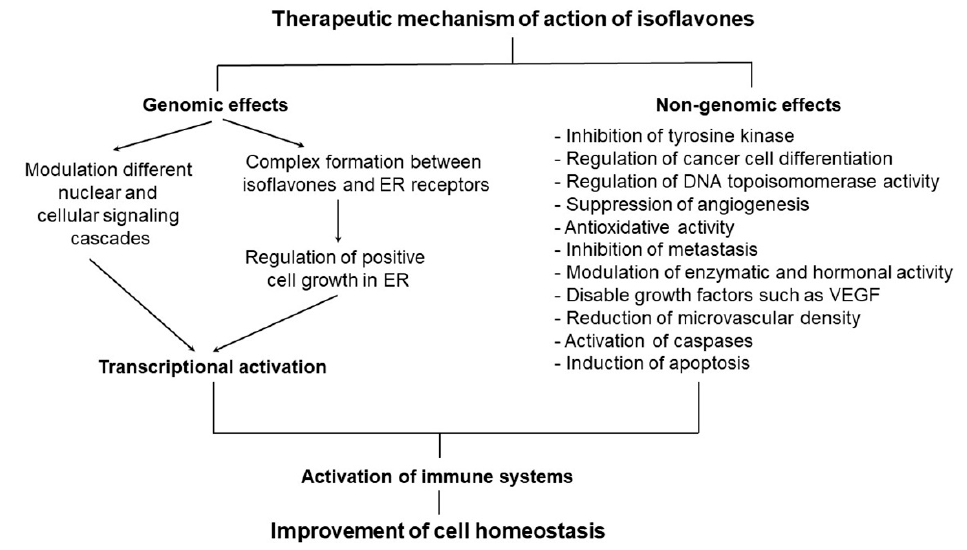
Figure 6. Mechanism of action of soybean isoflavones [12,30]. ER, endoplasmic reticulum; VEGF, vascular endothelial growth factor.